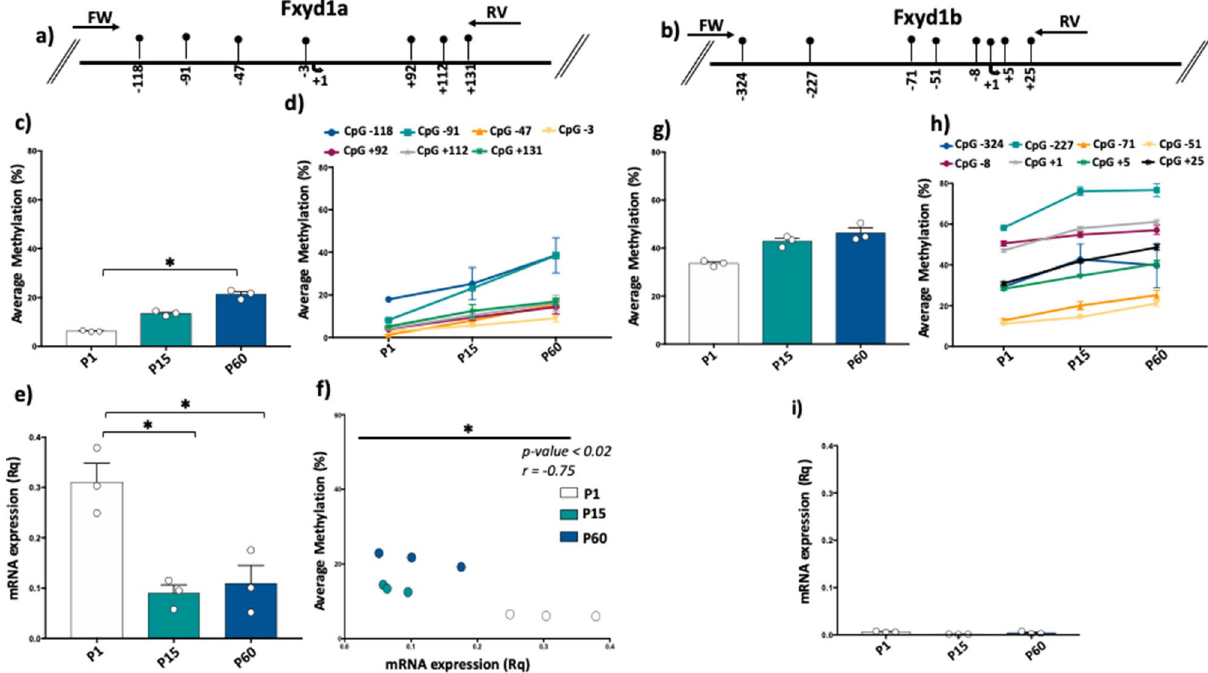
Figure 2. DNA methylation and mRNA expression of the Fxyd1 isoforms in the brain. ( a ) Fxyd1a gene promoter structure showing the analyzed CpGs. Seven CpG sites were analyzed at Fxyd1a promoter. The numbers of the CpGs are referred to the transcription starting site (TSS) indicated with the black arrow at + 1. Black arrows at the top specify the position of the primers used for bisulfite amplification. ( b ) Fxyd1b gene promoter structure showing the analyzed CpGs. Eight CpG sites were analyzed at Fxyd1b gene. The numbers of the CpGs refer to the transcription starting site (TSS) indicated with the black arrow at + 1. Black arrows at the top specify the position of the primers used for bisulfite amplification. ( c ) Fxyd1a average methylation (%) showed at P1, P15 and P60 developmental stages. Comparisons between developmental stages were performed using One-way ANOVA followed by Multiple t test. ( d ) Average methylation at single CpG sites displaying the methylation trend in the different developmental stages at Fxyd1a promoter. ( e ) mRNA expression levels of Fxyd1a referred to each developmental stage. Fxyd1a mRNA expression was normalized to the mean of the housekeeping gene and is expressed as 2 –ΔCt values. Comparisons between developmental stages were performed using One-way ANOVA followed by Multiple t test. ( f ) Pearson correlation between Fxyd1a mRNA expression and Fxyd1a promoter methylation at all analyzed developmental stages. ( g ) Fxyd1b average methylation (%) is showed at P1, P15 and P60 developmental stages. ( h ) Average methylation at each of analyzed CpG sites at Fxyd1b locus at the different developmental stages. ( i ) Expression levels of Fxyd1b referred to each developmental stage. Fxyd1b mRNA expression was normalized to the mean of the housekeeping gene and is expressed as 2 –ΔCt values. Comparisons between developmental stages were performed using One-way ANOVA followed by Multiple t test.*p <